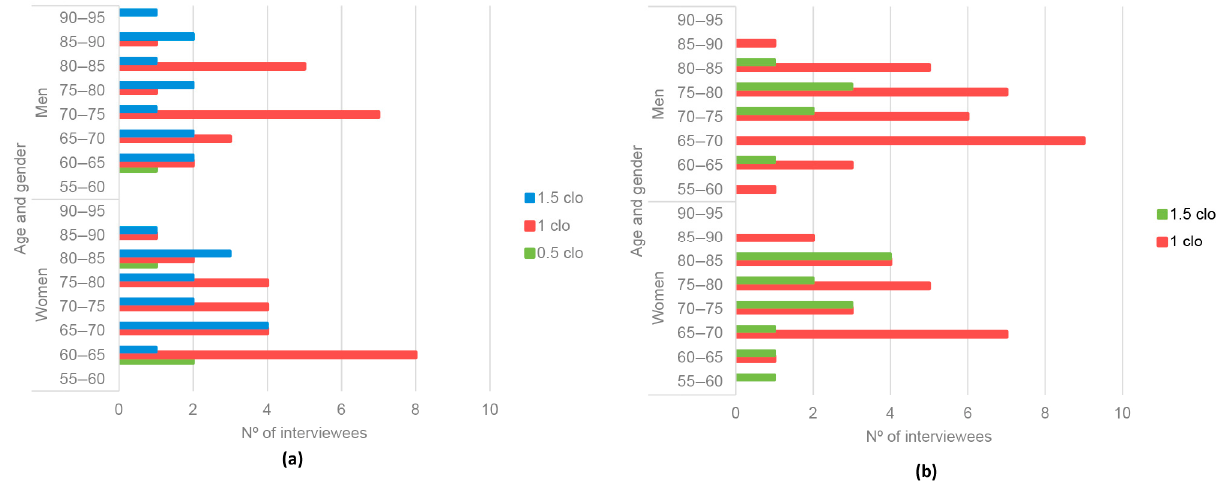
Figure 5. Sample characteristics. ( a ) Madrid; ( b ) Newcastle upon Tyne.